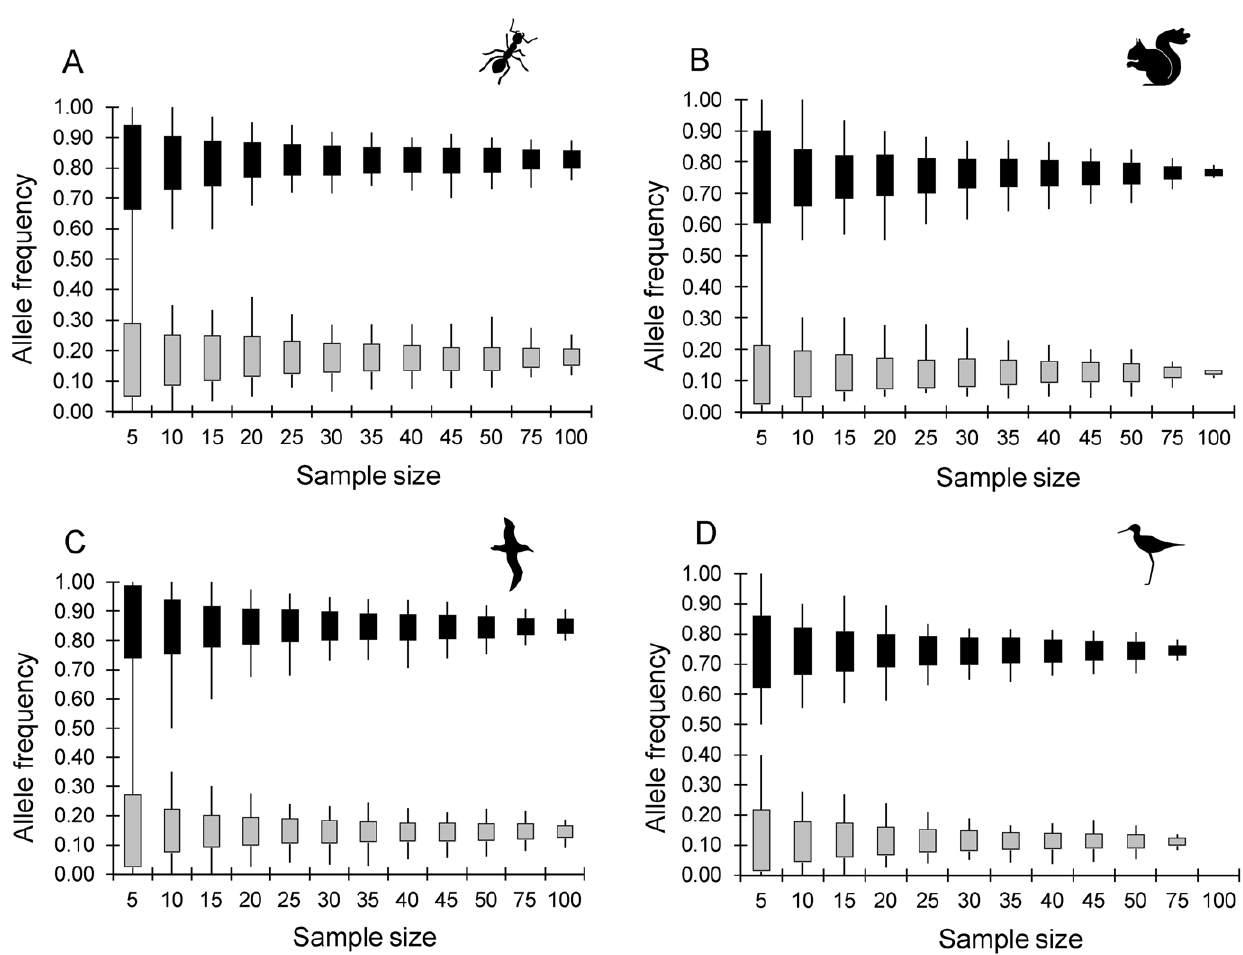
Figure 3. Impact of sample size on the precision of sample allele frequencies. The range (lines) and mean 6 one standard deviation (solid boxes) of allele frequencies of the 100 random replicates at each sample size for one common and one relatively rare allele in A) the ant dataset, B) the squirrel dataset, C) the albatross dataset and D) the kakı¯ dataset. The alleles are: A) allele 159 at locus FE16 (grey boxes, real frequency =0.176) and allele 116 at locus FE17 (black boxes, real frequency =0.833); B) allele 196 at locus Scv8 (grey boxes, real frequency =0.126) and allele 162 at locus Scv23 (black boxes, real frequency =0.766); C) allele 187 at locus De35 (grey boxes, real frequency =0.147) and allele 165 at locus D5 (black boxes, real frequency =0.852); and D) allele 241 at locus Kakı¯_21 (grey boxes, real frequency =0.112) and allele 200 at locus Kakı¯_27 (black boxes, real frequency =0.745).